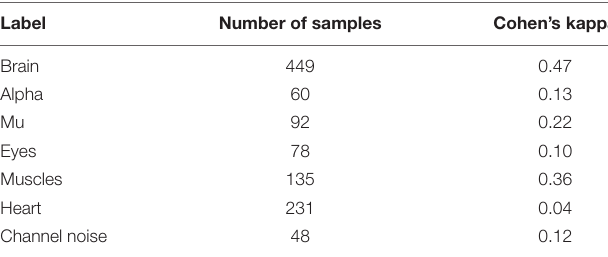
TABLE 2 | Number of samples and Cohen’s kappa for each class.